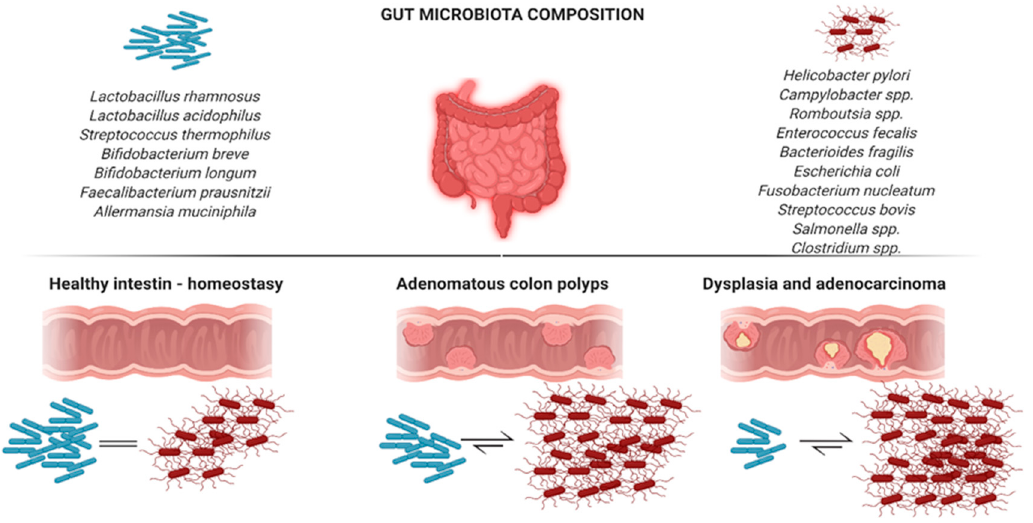
Figure 1. Changes in the gut microbiota composition in healthy colon, adenoma colon, and carcinoma colon.